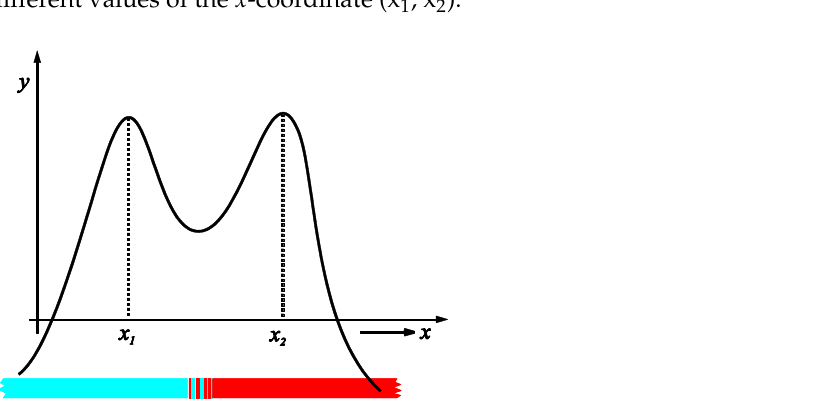
Figure 4. Numerical method in the case of a function with two maxima (the method is started at a specific point and will be terminated when the maximum is reached).